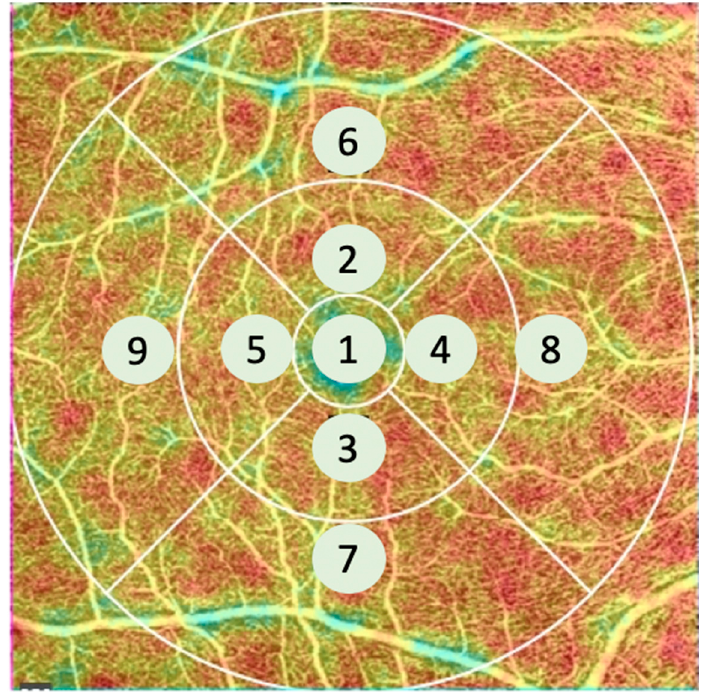
Figure 1. Example of a right eye. The 9 areas of the ETDRS (Early Treatment of Diabetic Retinopathy Study) grid were numbered so that area 8 was the most adjacent and area 9 was the most temporal to the optic nerve head.